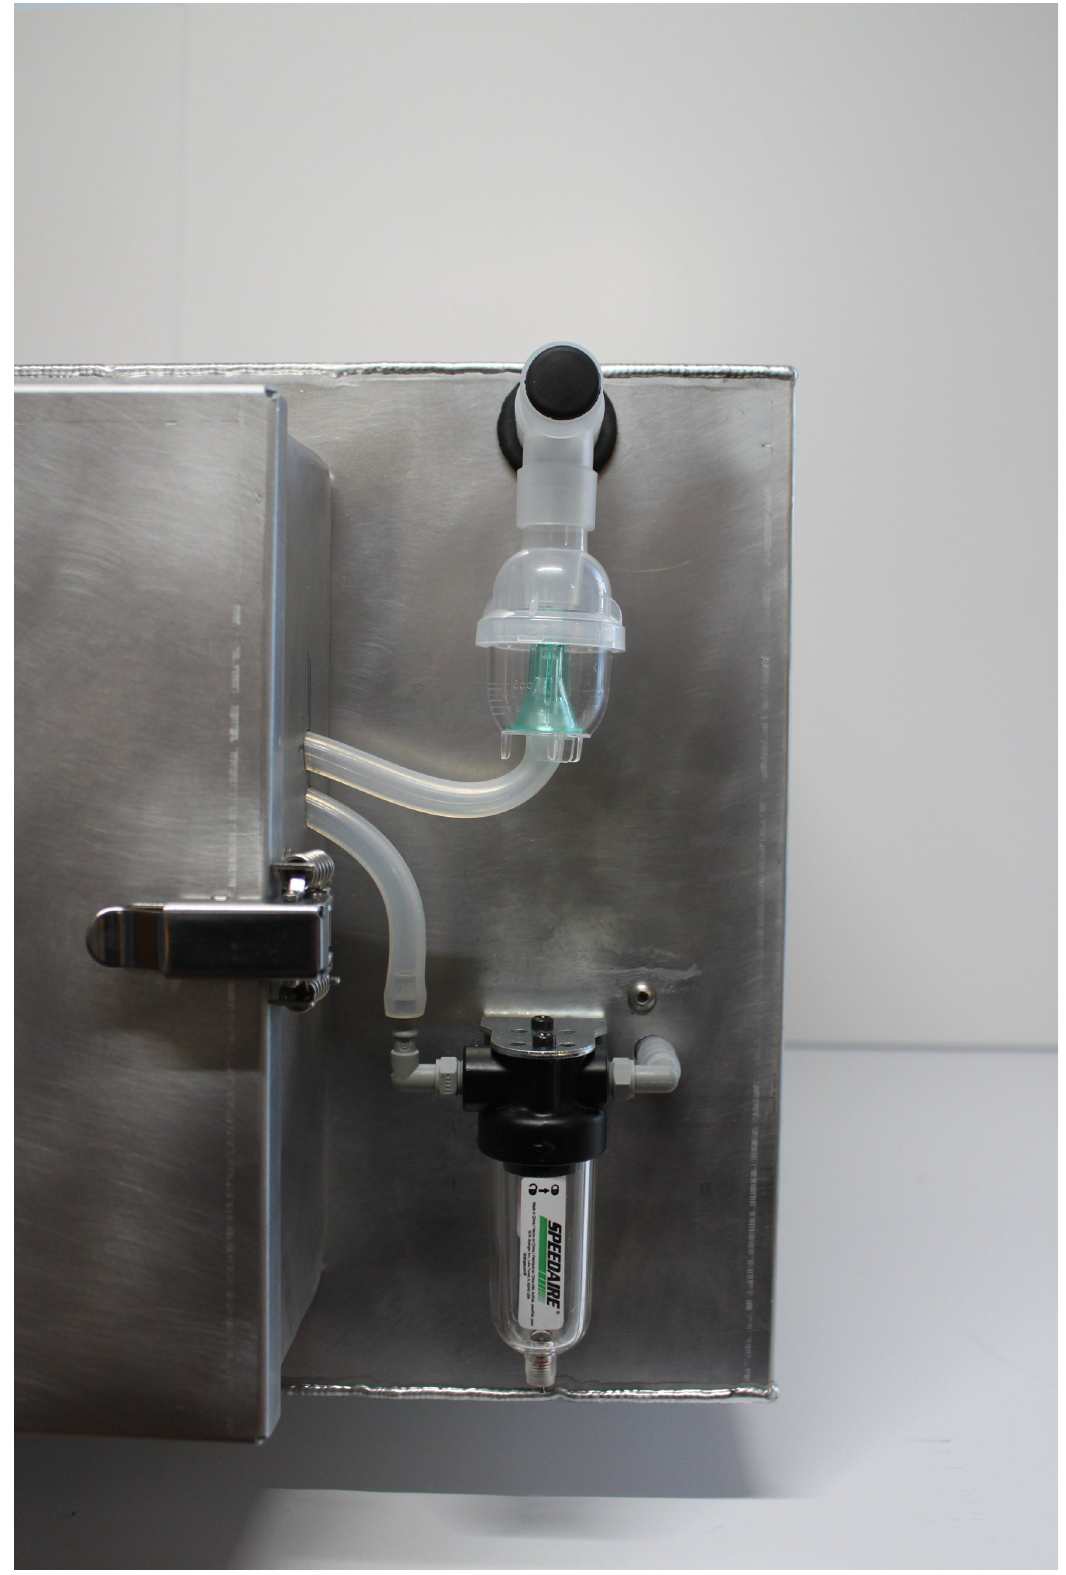
Fig 3. Arca exterior showing nebulizer (top), condenser unit (bottom), and electronics housing (left). https://doi.org/10.1371/journal.pone.0273937.g003 PLOS ONE | https://doi.org/10.1371/journal.pone.0273937 September 20,